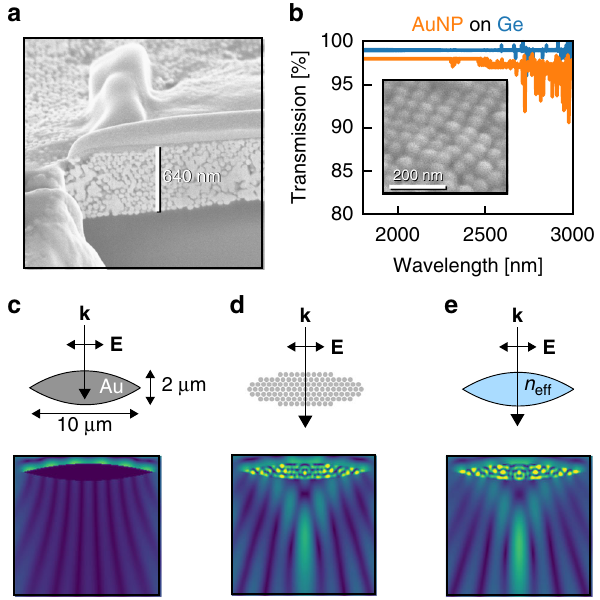
Fig. 3 Experimental and numerical demonstrations of transparent metallic arrays. a Microscopy image of 60 nm diameter gold colloidal supercrystal deposited on a Ge substrate. b The metallic particles show high infrared transparency. c – e The effective dielectrics are transparent enough to act as micrometer-scale lenses to infrared radiation of wavelength λ 0 = 2 μ m, as shown by the magnetic near- fi elds. There is good agreement between d the full geometry of titanium cylinders with diameter 38 nm and surface-to- surface gap 2 nm and e the homogenised geometry, n eff = 3.2 + 0.5